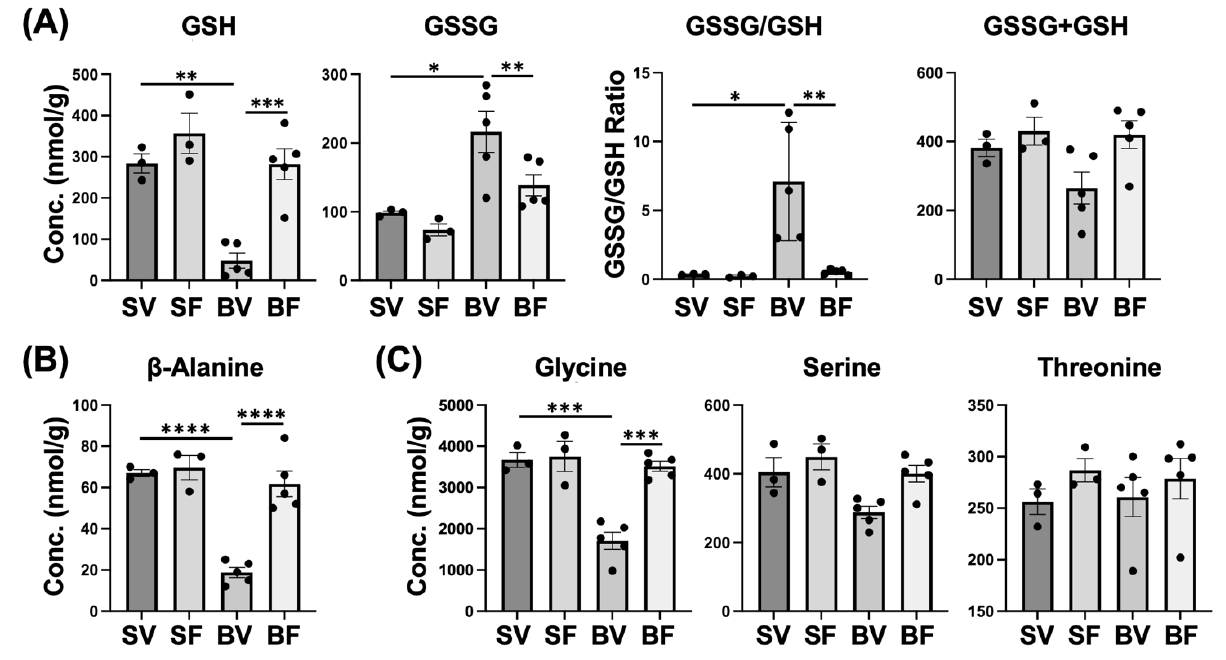
Figure 6. Effects of burn injury and FTI-277 on metabolites related to glutathione ( A ), β -alanine ( B ), glycine, serine, and threonine metabolism ( C ). SV: Sham-Vehicle; SF: Sham-FTI; BV: Burn-Vehicle; BF: Burn-FTI, GSH: reduced glutathione, GSSG: oxidized glutathione, * p < 0.05, ** p < 0.01, *** p < 0.001, **** p < 0.0001.